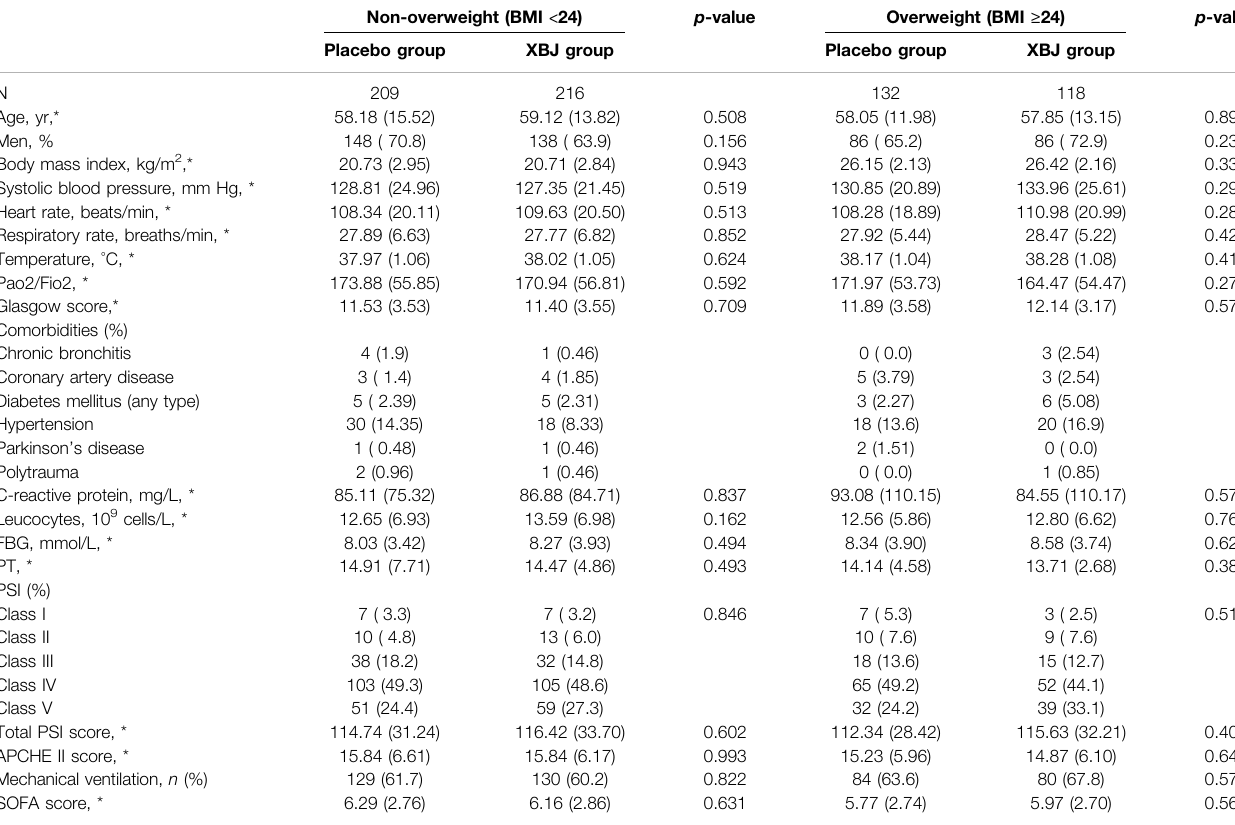
TABLE 1 | Demographic and basal clinical characteristics of patients between XueBiJing and placebo groups in the BMI